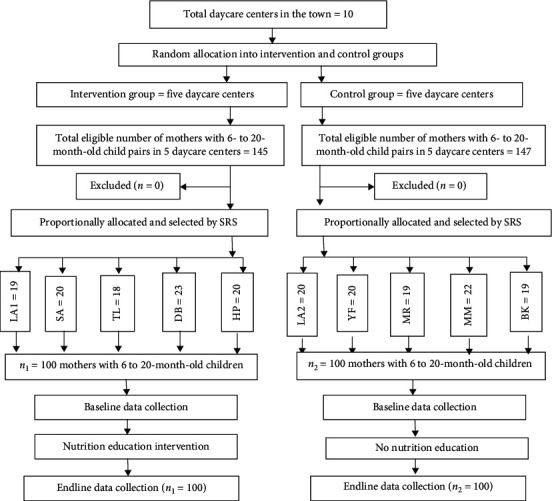
Schematic diagram for sampling techniques and group assignment. LA1 = little angles 1 (N = 26), SA = S. Arsema (N = 28), TL = true love (N = 28), DB = dibora (N = 32), HP = hope (N = 31), LA2 = little angles 2 (N = 28), YF = Yenat Fikir (N = 28) MR = Mercy (N = 29), MM = Mami (N = 32), BK = Barkot (N = 30), SRS = simple random sampling.